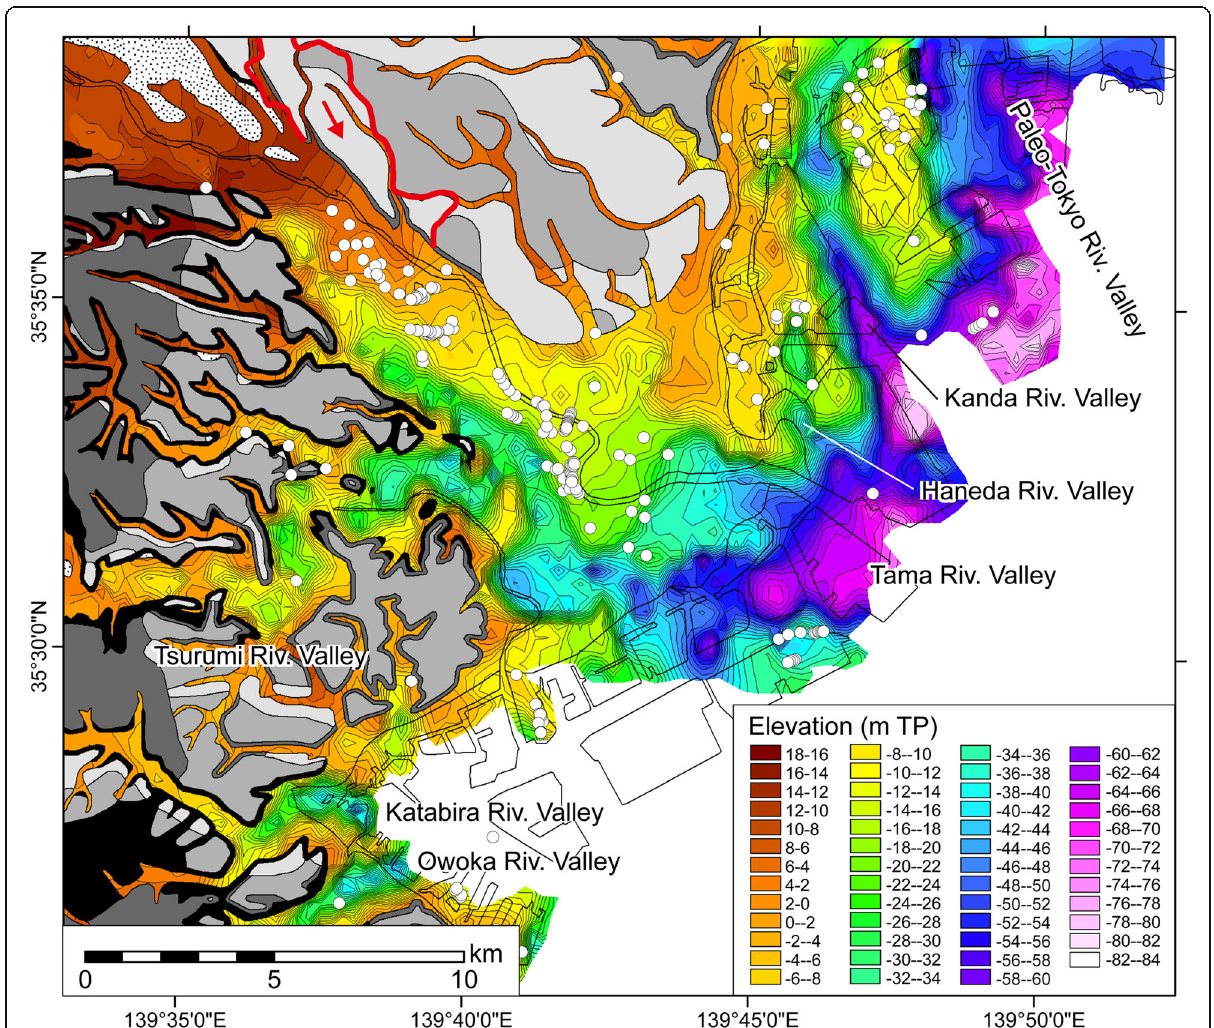
Fig. 7 Elevation map of post-MIS 5a buried terraces and LGM incised valleys in and around the Tama River Lowland. The white dots show the distribution of the Kanto Loam on buried terraces. The contour interval is 2 m. The base of the BG is the base of the post-LGM incised-valley